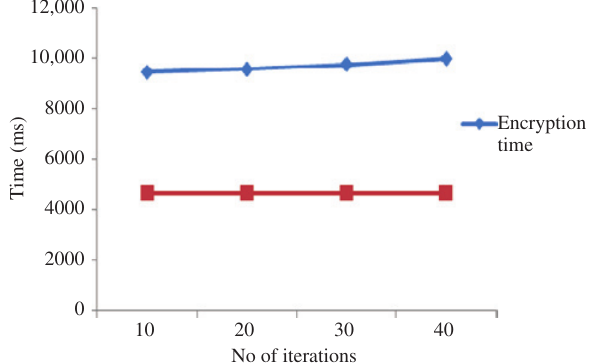
Figure 3: Encryption and Decryption Time by Varying the Number of Iteration Using OAES.